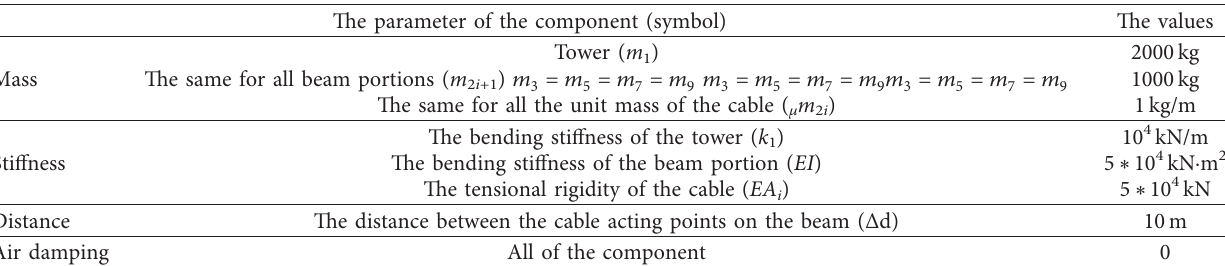
Figure 8: The simplified model of parametric resonance for the multicable system. Table 2: The basic parameters of the components in the Ci subsystem.